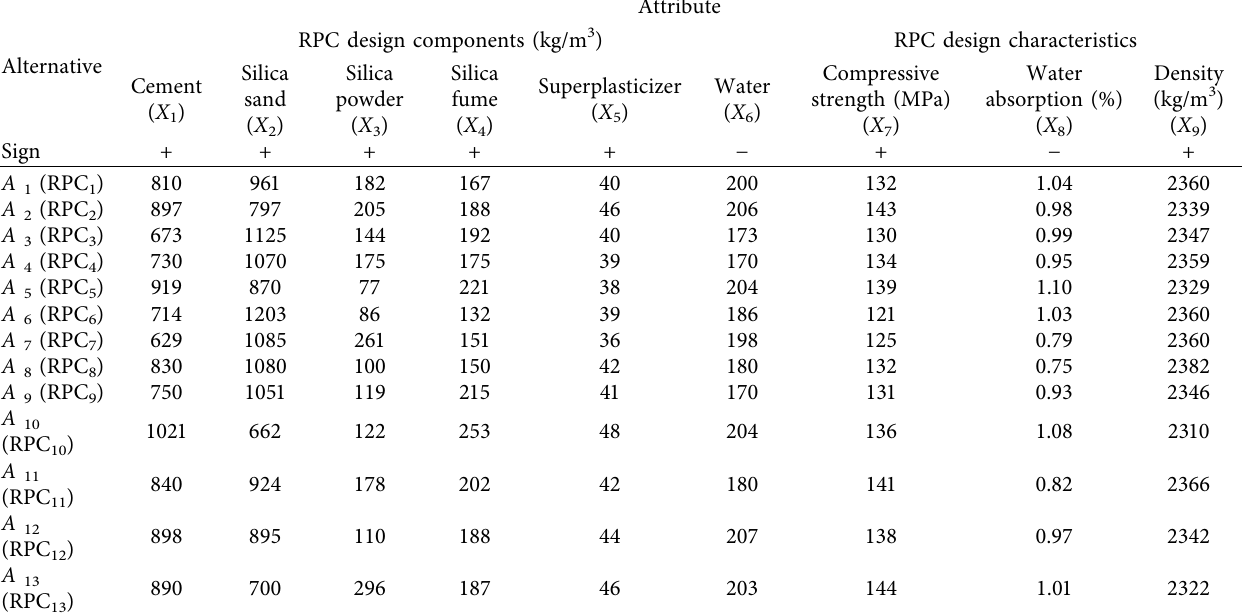
Table 8: Decision